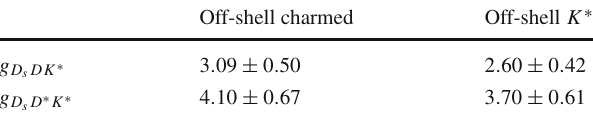
Table 3 The coupling constant of the vertices D s DK ∗ and D s D ∗ K ∗